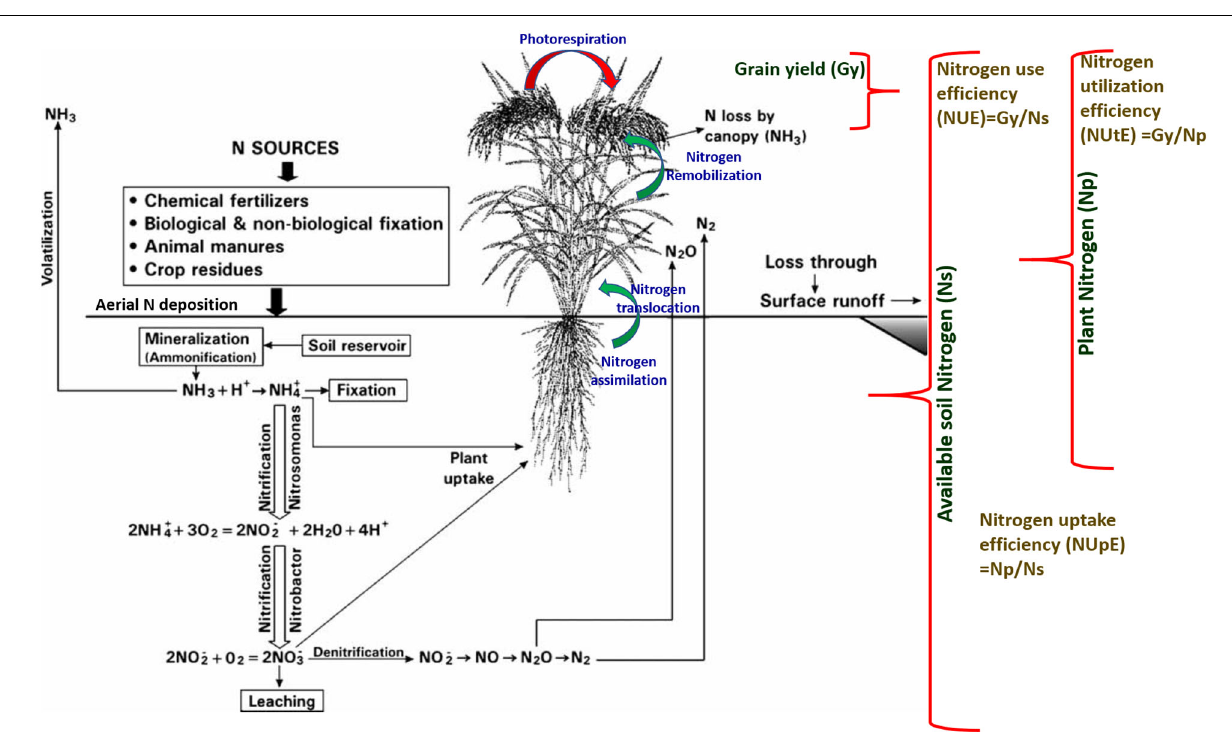
FIGURE 2 | Schematic representation of the relationship between the nitrogen sources, key physiological processes for the nitrogen assimilation, translocation, remobilization, uptake, utilization, and conversion to the grain